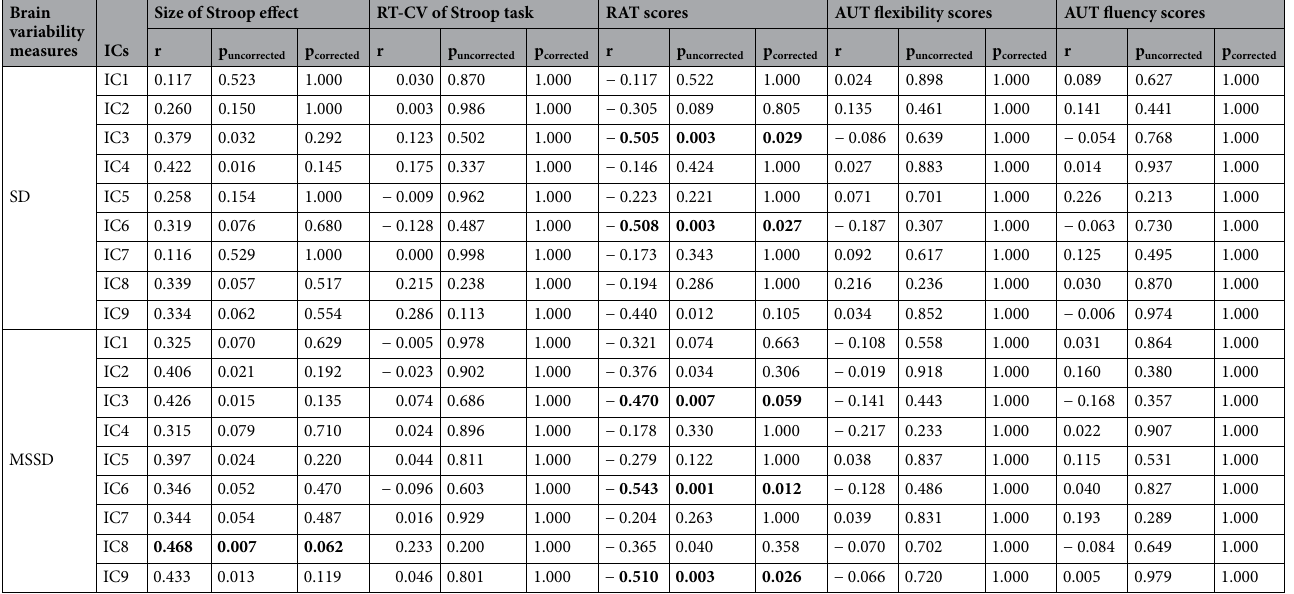
Table 2. Correlations between brain variability measured by SD, MSSD, and metacontrol policies measured by the size of Stroop effect, IIV of Stroop performance (RT-CV), RAT scores, AUT flexibility scores, and AUT fluency scores. Spearman correlation was used for RAT scores, AUT flexibility scores and AUT fluency scores. IC independent component, SD standard deviation, MSSD mean squared successive difference, RT- CV coefficient of variation in reaction time, RAT remote associates task, AUT alternate uses task, P corrected Bonferroni corrected p value. Significant values are in bold.